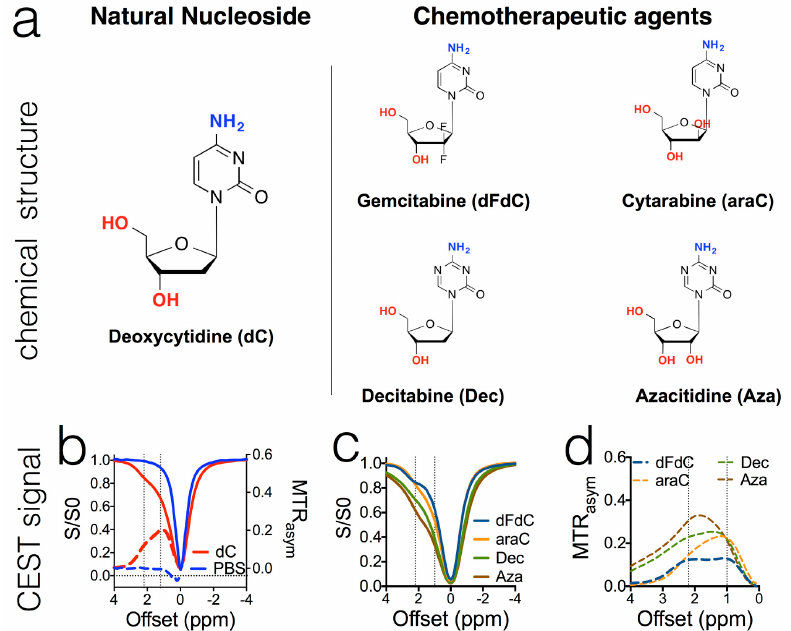
Figure 6. The chemical structure of cytidine-based agents ( a ) and their CEST MRI contrast, as shown both by z-spectra ( b , c ) and MTR asym plots ( b , d ). All samples were prepared in PBS (pH 7.4) at a concentration of 20 mM and measured at 37 °C using a 3.6 µT, 3 s CW RF pulse. Reprinted with permission from Ref [59].